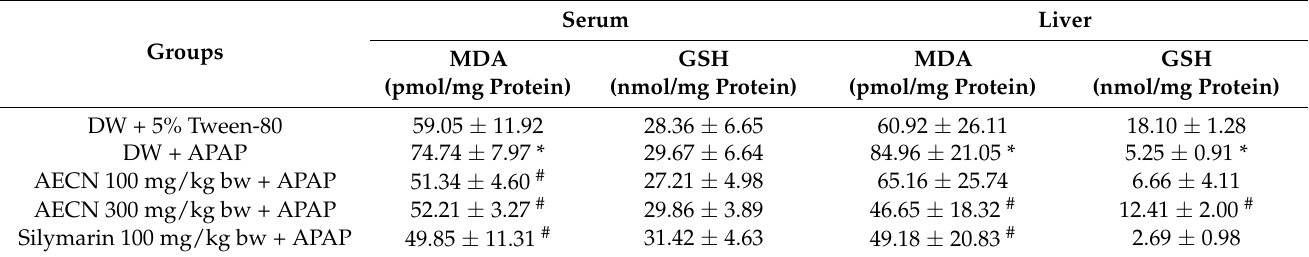
Table 2. Effect of AECN on certain oxidative stress markers in the serum and livers of APAP-treated rats.